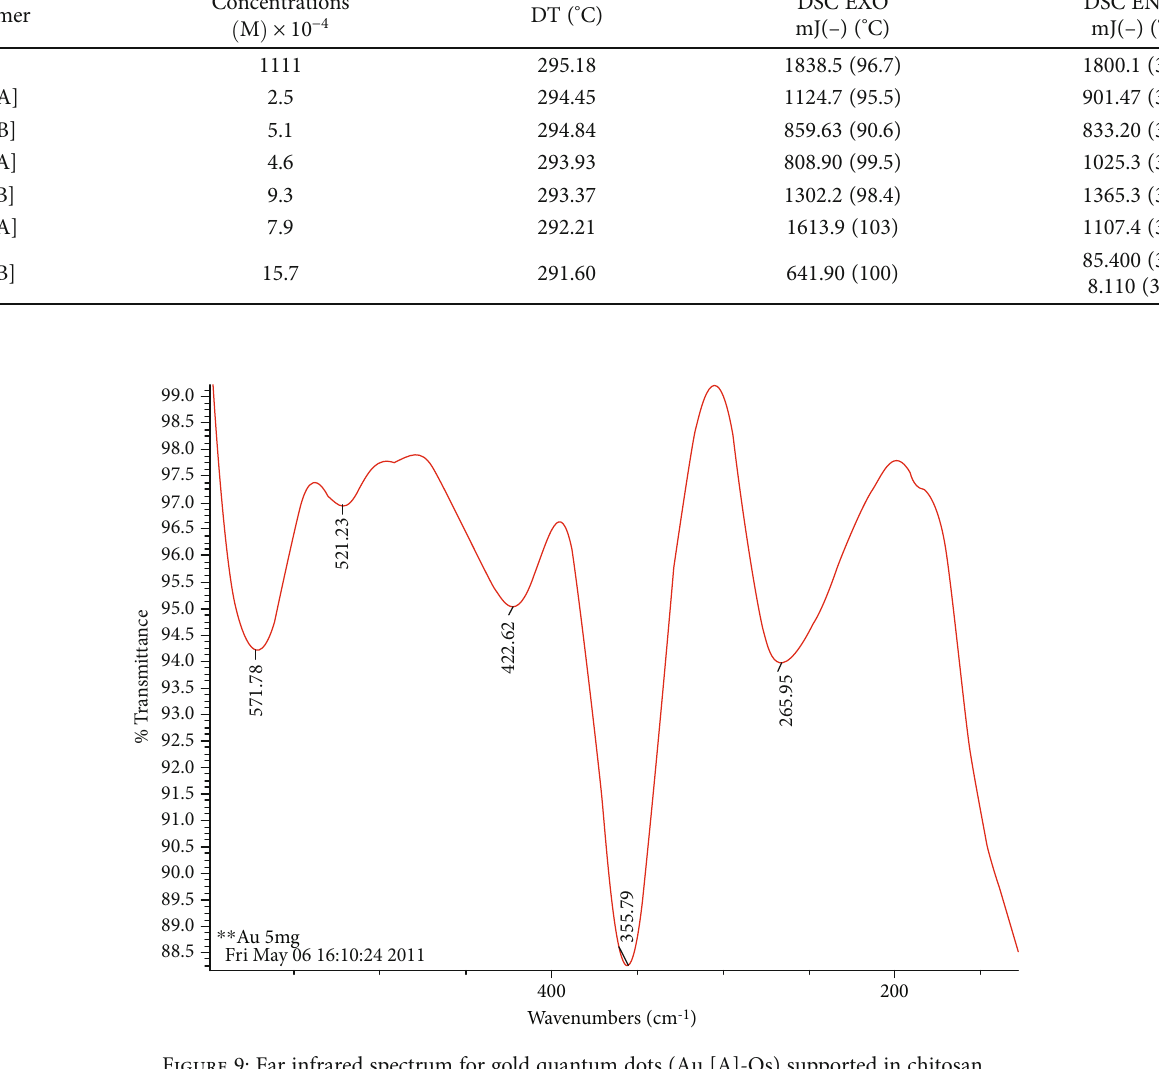
Table 4: Summary table of kinetic parameters for thermal degradation of chitosan and chitosan doped metal nanoparticles (MQDs). Polymer